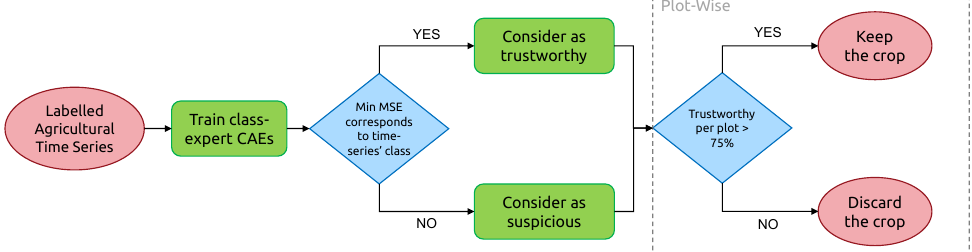
Figure 11. Trustworthy crops filtering process for Quantitative